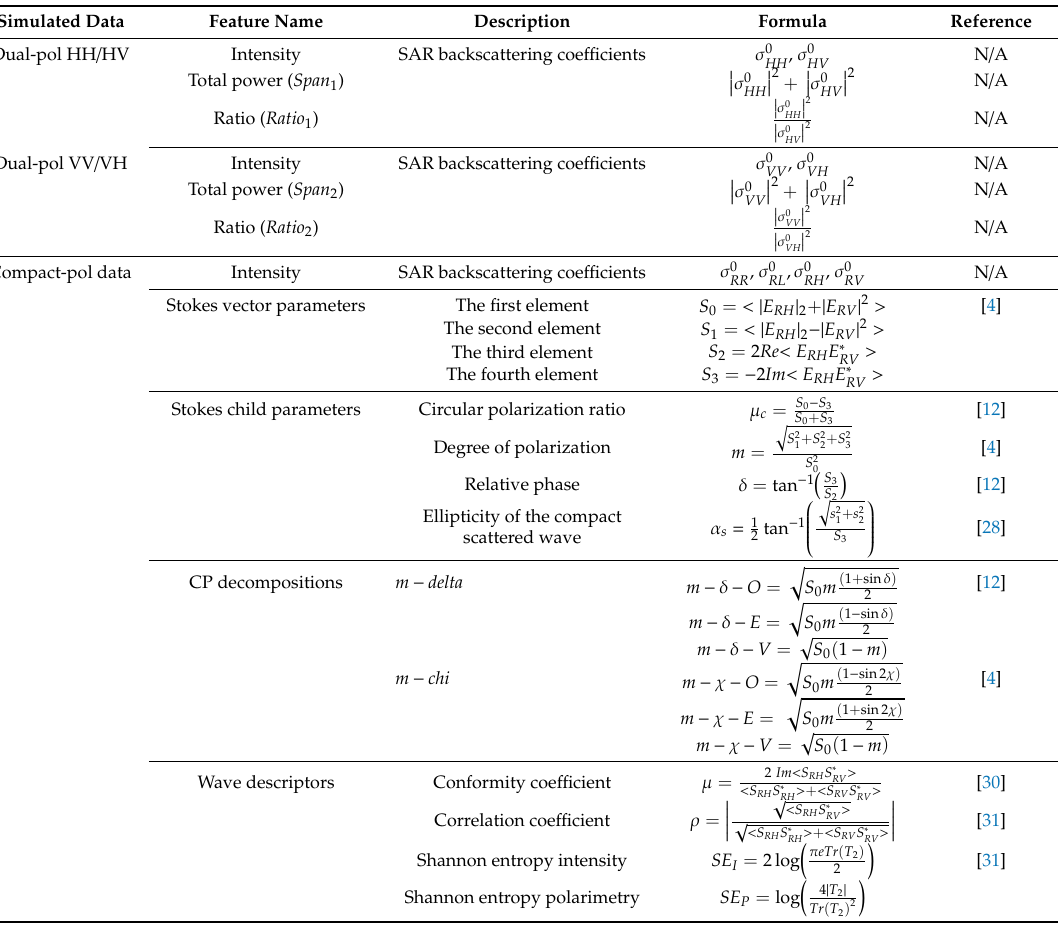
Table 2. A description of simulated SAR features employed in this